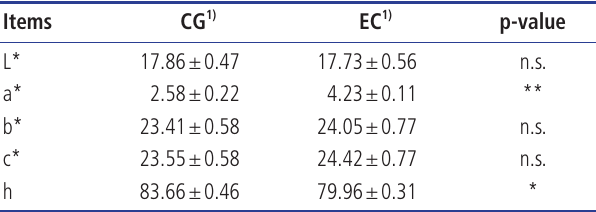
Table 3. Coloration of egg yolks obtained from control and experimental group Items